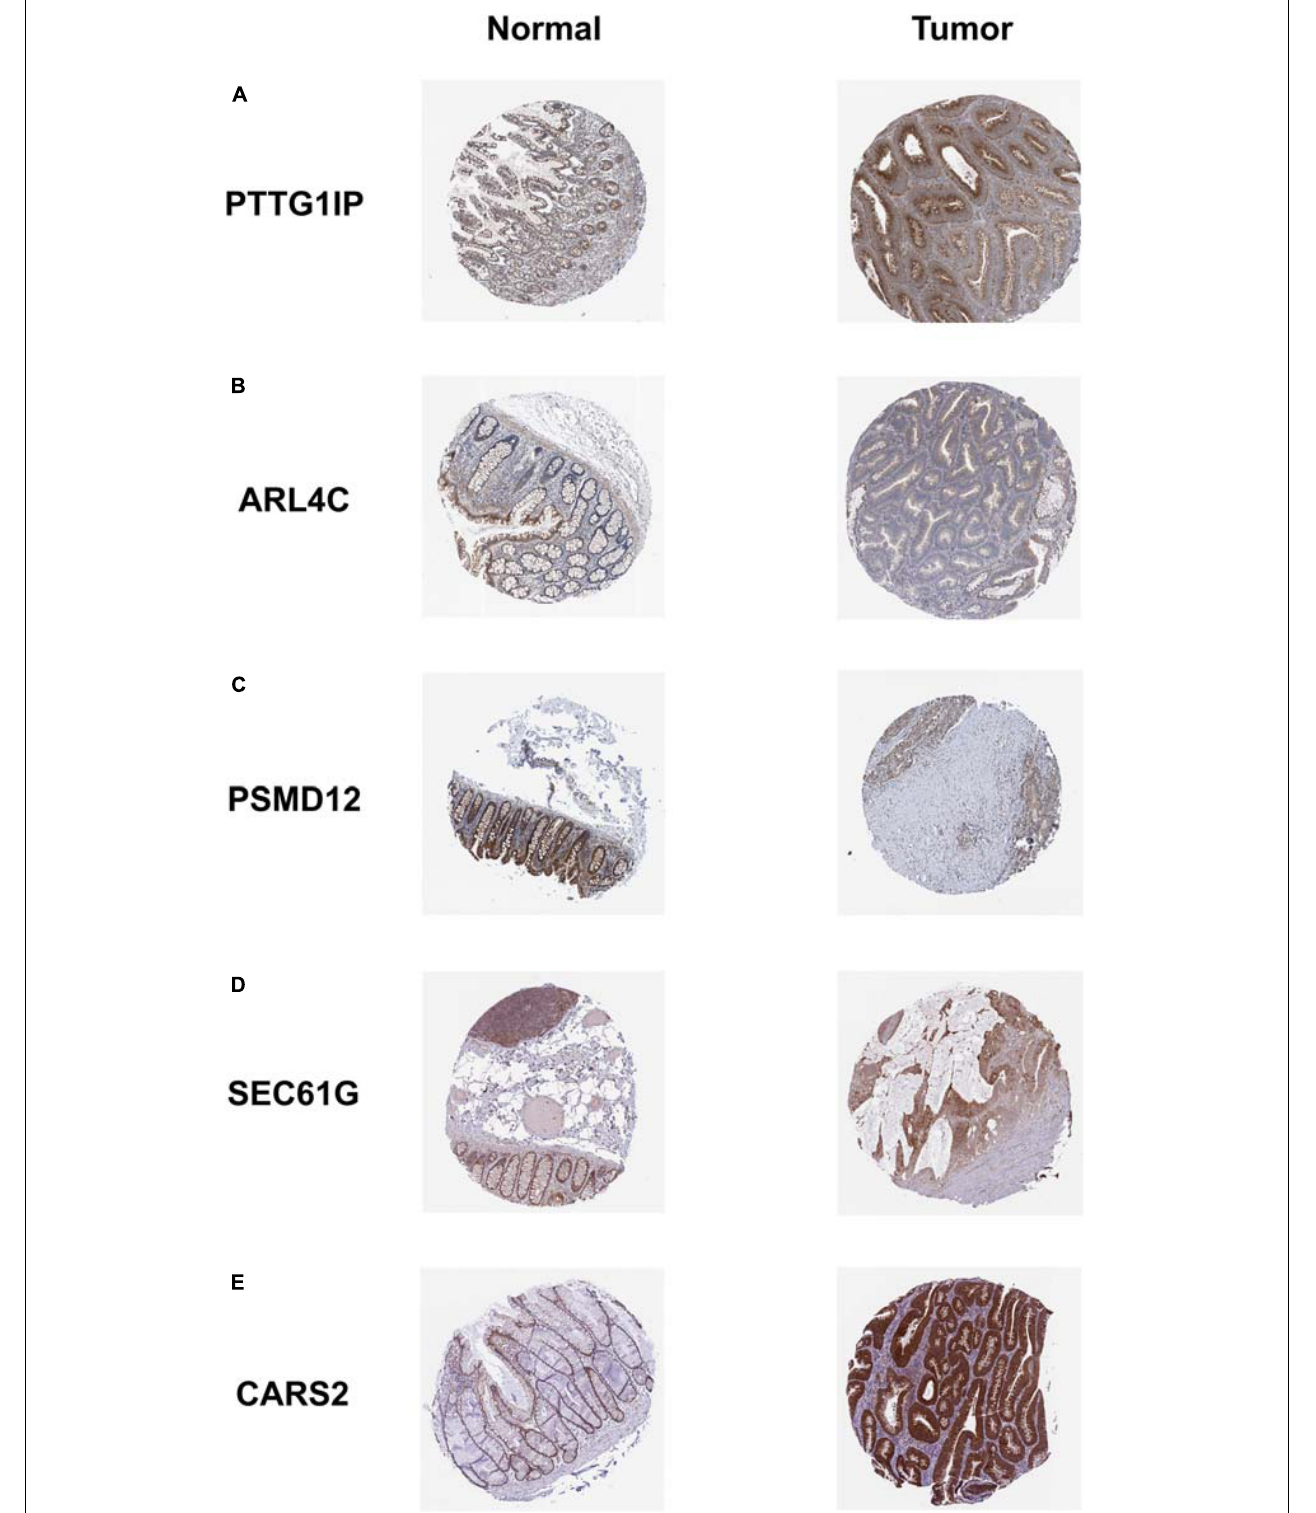
FIGURE 12 | Immunohistochemical staining results of model genes. The expression trend of each model gene in tissues is basically consistent with the corresponding risk attribute. (A) PTTG1IP; (B) ARL4C; (C) PSMD12; (D) SEC61G; (E) CARS2.